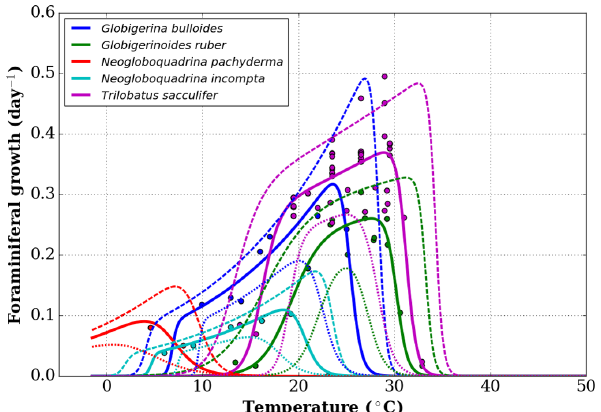
Figure A1. Growth functions corresponding to Eq. (1) over the full temperature range considered, with added lower-range and upper- range curves (respectively, short and long dashed curves) chosen to mimic the 95% confidence interval of Lombard et al. (2009). Data points are the original data obtained by Lombard et al. (2009).